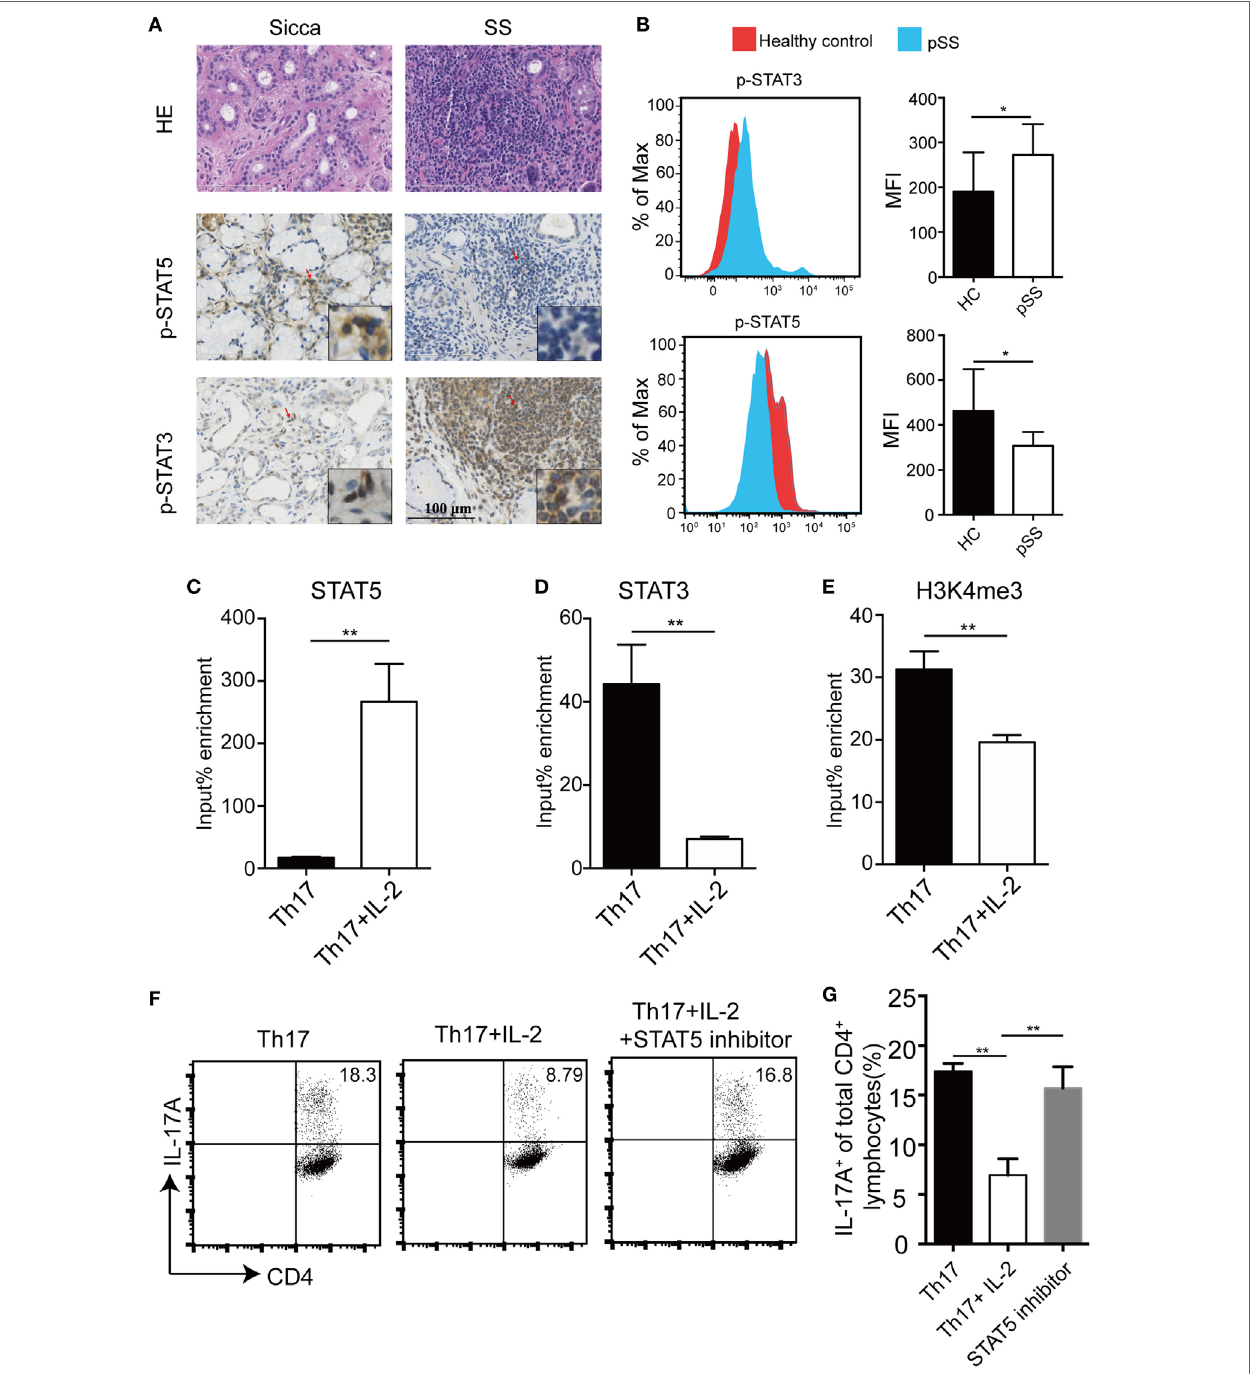
FigUre 4 | IL-2-induced STAT5 binds to STAT3-binding site in human Il17a locus. (a) H&E and IHC staining with anti-p-STAT3 and anti-p-STAT5 antibody on the minor salivary gland (MSG) tissues from 10 primary Sjögren’s syndrome (pSS) patients and 7 Sicca patients. Representative images are shown. (b) The levels of p-STAT3 and p-STAT5 in CD4 + T cells in the PBMCs from healthy donors ( n = 5) or pSS ( n = 5) patients were determined by flow cytometry. Representative plot (left) and histogram analysis (right) were shown. (c–e) Naïve CD4 + T cells were stimulated under Th17 conditions with or without IL-2, then crosslinked, and immunoprecipitated with anti-STAT5 (c) , anti-STAT3 (D) , and anti-H3K4me3 (e) . Immunoprecipitated DNA was amplified by q-PCR and expressed as a percentage to input DNA. (F,g) Human naïve CD4 + T cells were differentiated under Th17 conditions with IL-2 by adding STAT5 inhibitor STAT5-IN-1 (5 µM) for 8 days. The percentages of CD4 + IL-17A + cells were determined by intracellular staining (F) . Histogram analysis of the percentages of the differentiated Th17 cells treated with or without STAT5 inhibitor (g) . P value was determined with unpaired t -test. Data are pooled from two independent experiments (error bars denote SEM). * p < 0.05, ** p < 0.01.